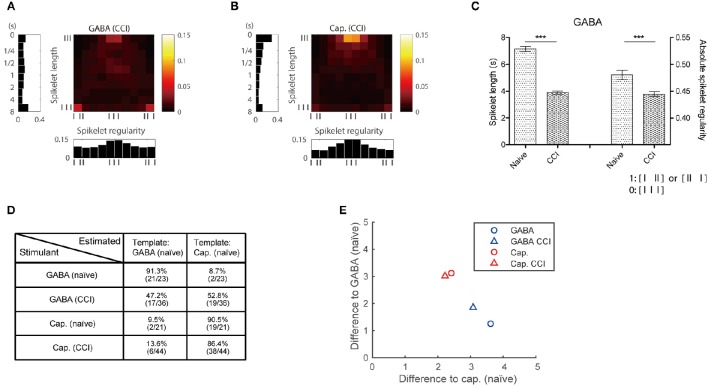
Temporal discharge patterns in pathological condition. (A,B) 2D map of responses in CCI mice to GABA and capsaicin, respectively. (C) Spikelets of GABA responses are shorter and more regular in CCI mice than naïve mice. (Mann–Whitney or t-test based on normality, ***P < 0.001) (D) Classification performance using KL divergence of the GABA and capsaicin patterns. (E) Mean differences from individual 2D maps to GABA and capsaicin 2D maps (Figures 4C,D).